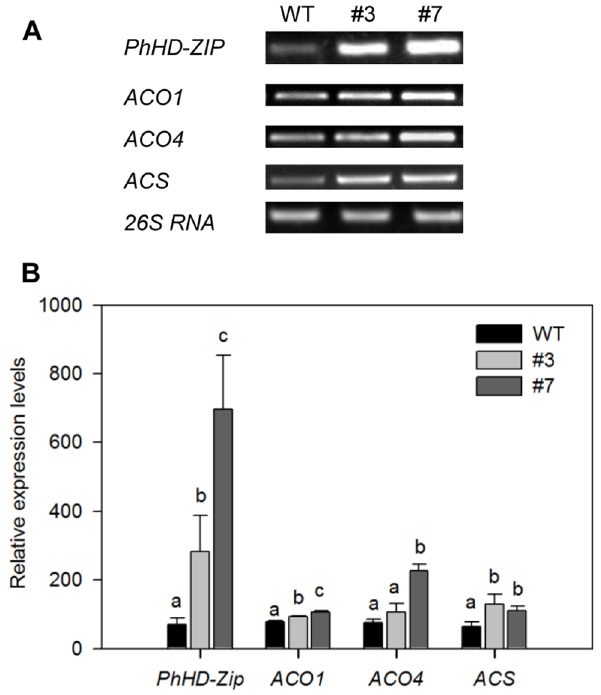
Figure 8. Effect of transgenic over-expression of PhHD-Zip on abundance of transcripts of PhHD-Zip and of ethylene biosyn- thesis genes in petunia corollas. WT: wild type flower; # 3, # 7: two transgenic lines of 35S:: PhHD-Zip . A. A representative gel image from semi-quantitative PCR of RNA isolated from harvested corollas. 26S RNA: the internal control. Samples were analyzed after 30 cycles for PhHD-Zip, ACO1 and ACO4 ; after 33 cycles for ACS ; and after 24 cycles for 26S RNA . B. Relative expression level of PhHD-Zip and ethylene biosynthesis genes (quantification of the gel pictures; error bars show SE of the means of three biological replicates; different letters denote significant differences using Duncan’s test at P , 0.05).